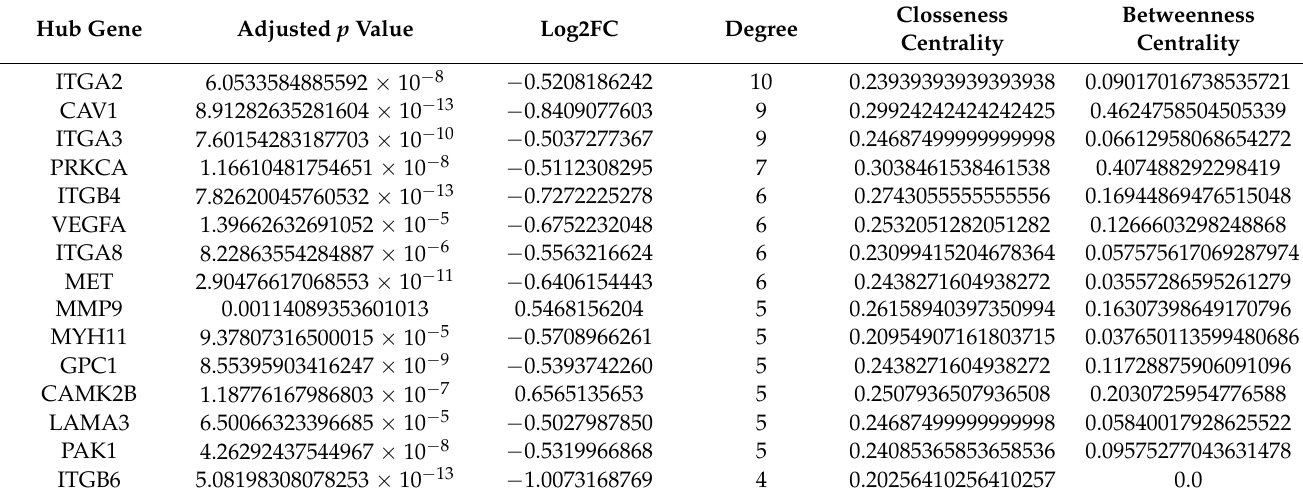
Figure 15. PPI network of DEmRNAs. ( A ) Total PPI network, ( B ) subnetwork of hub genes. Table 6. The information of hub genes in PPI network.